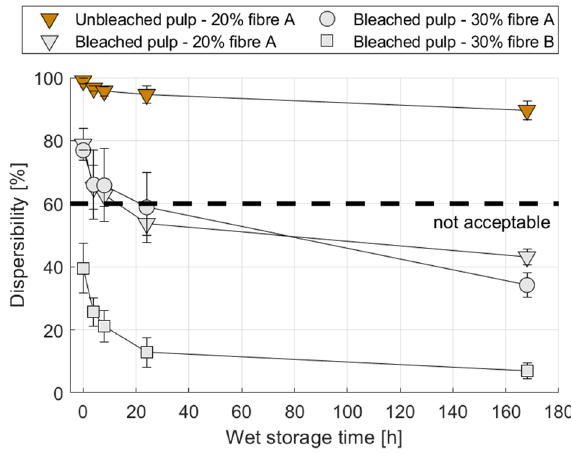
Figure 3. Reduction of wet wipe dispersibility due to storage in water for wipes produced from different raw materials (compare Table 2). Error bars represent one standard deviation.